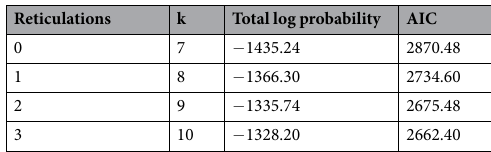
Table 3. Likelihood and AIC scores for different reticulation scenarios using the ML